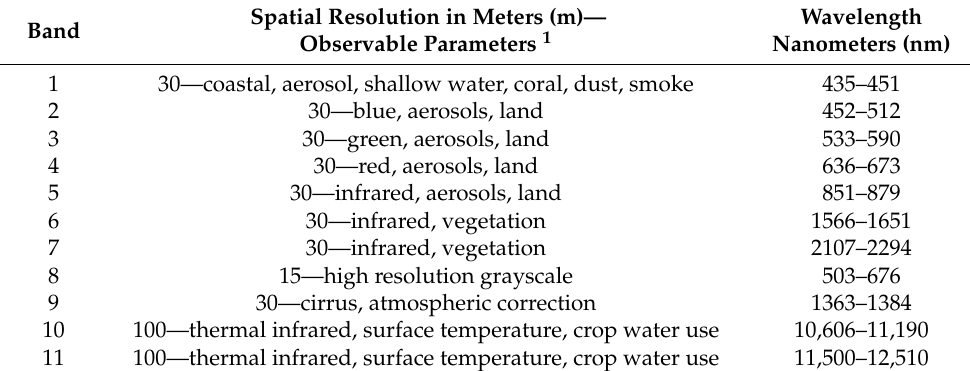
Table 1. Landsat 8, Landsat 9 Electromagnetic Spectrum Bands of